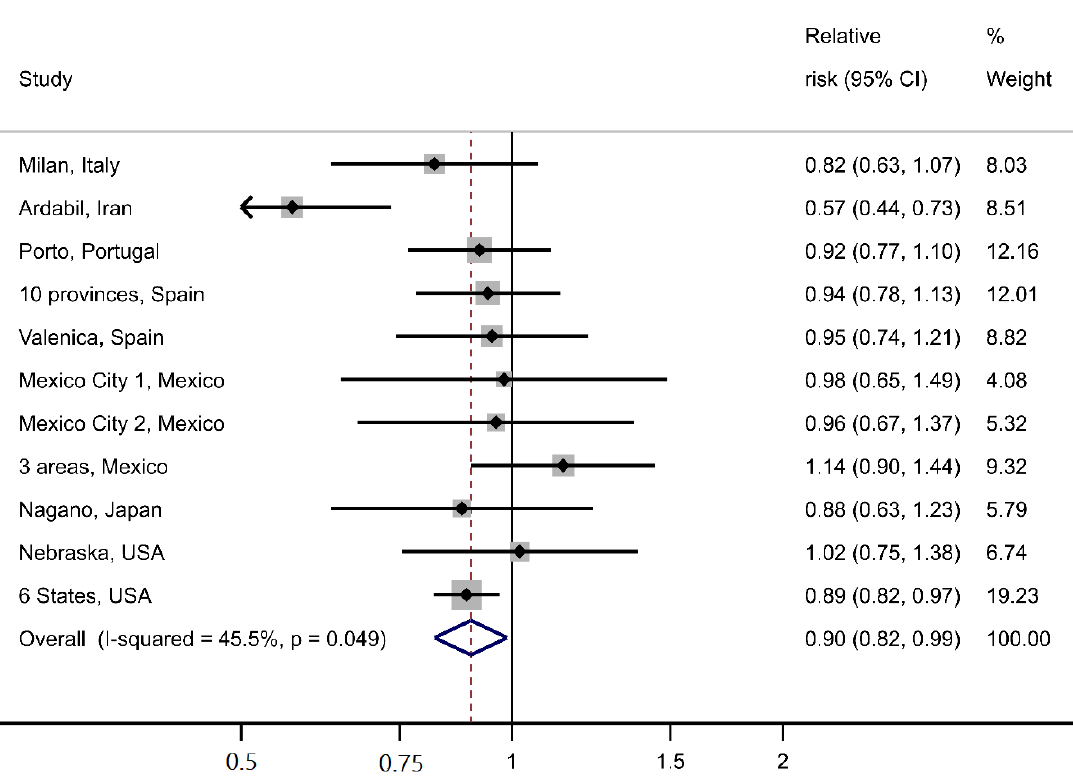
Figure 2. Meta-analysis of individual study results on the association between iron intake (one quartile increase) and gastric cancer.